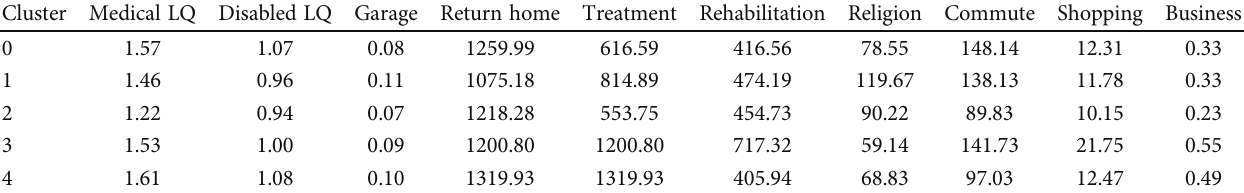
Figure 7: Percentage of demand occurrences by hour. Table 1: Mean feature vectors by